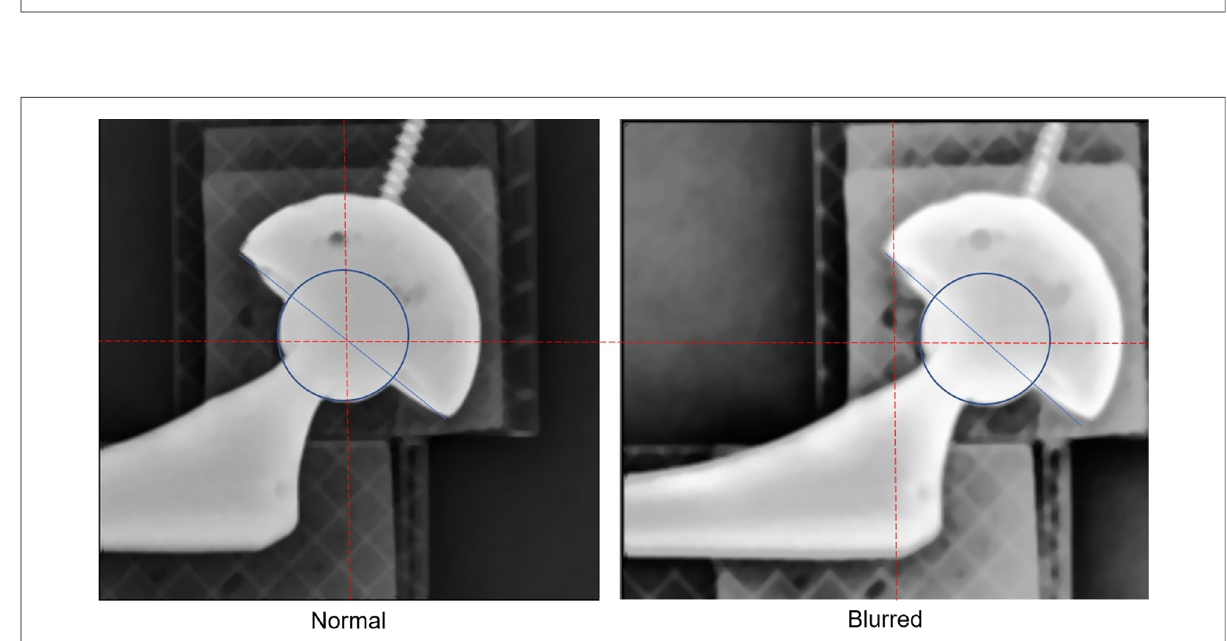
FIGURE 5 Eccentricity comparison test setup, i.e., nine spatial eccentricity modes. With respect to the center of the x-ray detector, nine spatial eccentricity locations of the THA prostheses were set up to fi gure out how the eccentricity of the component location affected PolyWare measurement results.